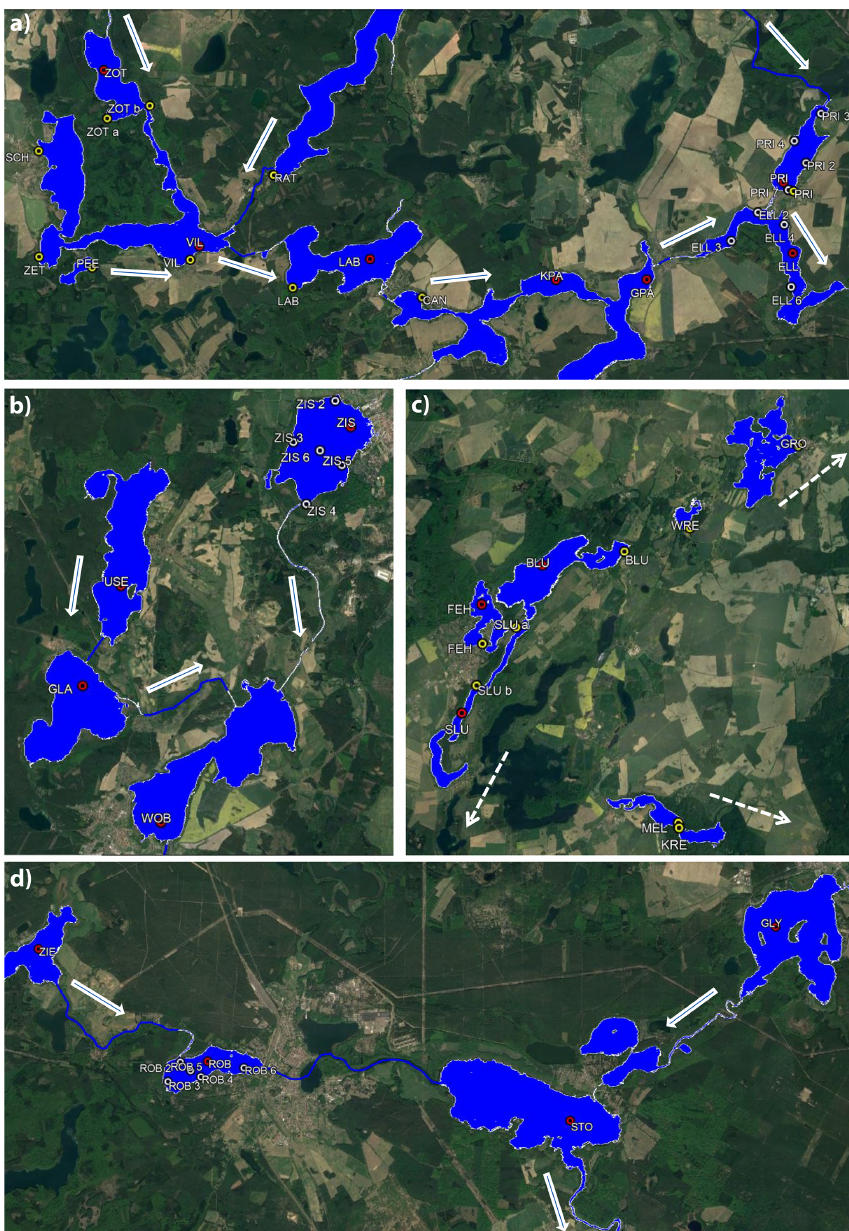
Figure 2. Sampling locations at (a) the Müritz–Havel, (b) the upper Havel, (c) Feldberg lakes, and (d) the Havel main branch. Shore samples taken in March and July 2020 are marked yellow. Time series samples from buoys in red. Spatial samples from lakes PRI, ELL, ZIS, and ROB in white. Arrows indicate streamflow direction. Underlying map © Google Earth 2021.